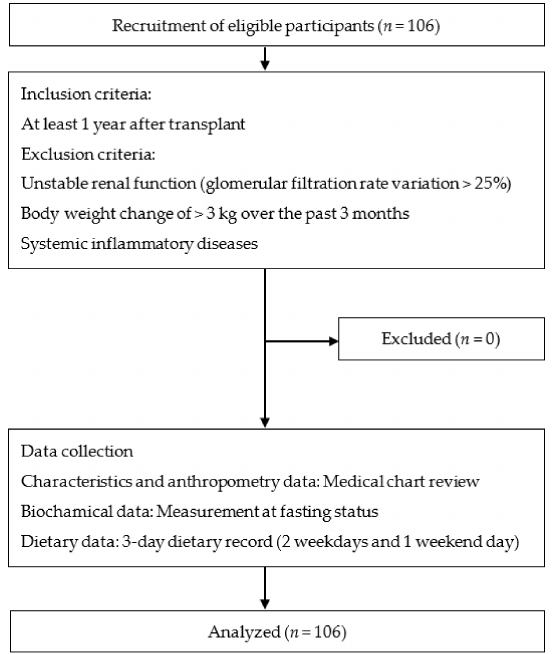
Figure 1. Study procedure and flowchart with patients’